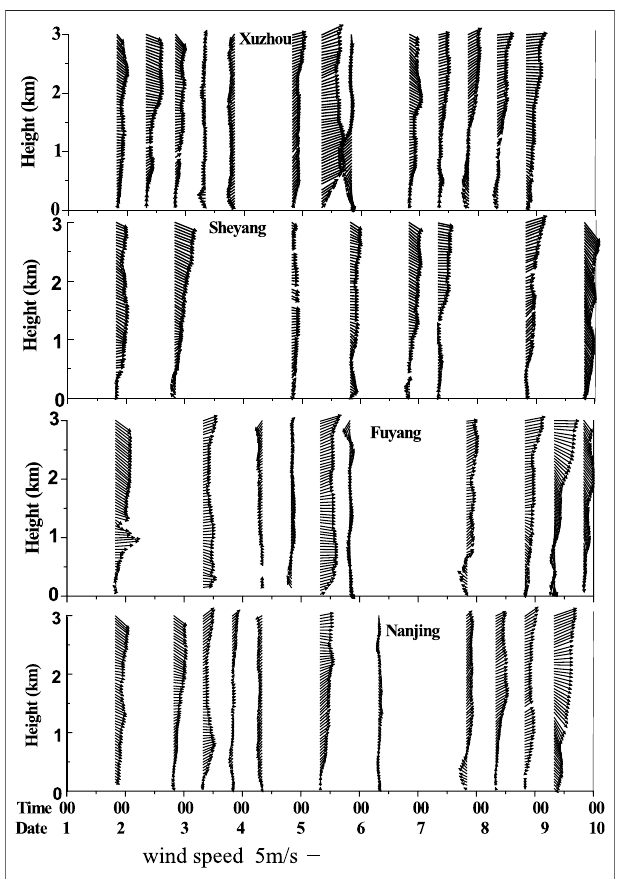
FIGURE 6 | Spatiotemporal cross-sections of the wind fi eld at Xuzhou, Sheyang, Fuyang, and Nanjing during Dec. 1 and Dec. 9, 2013.